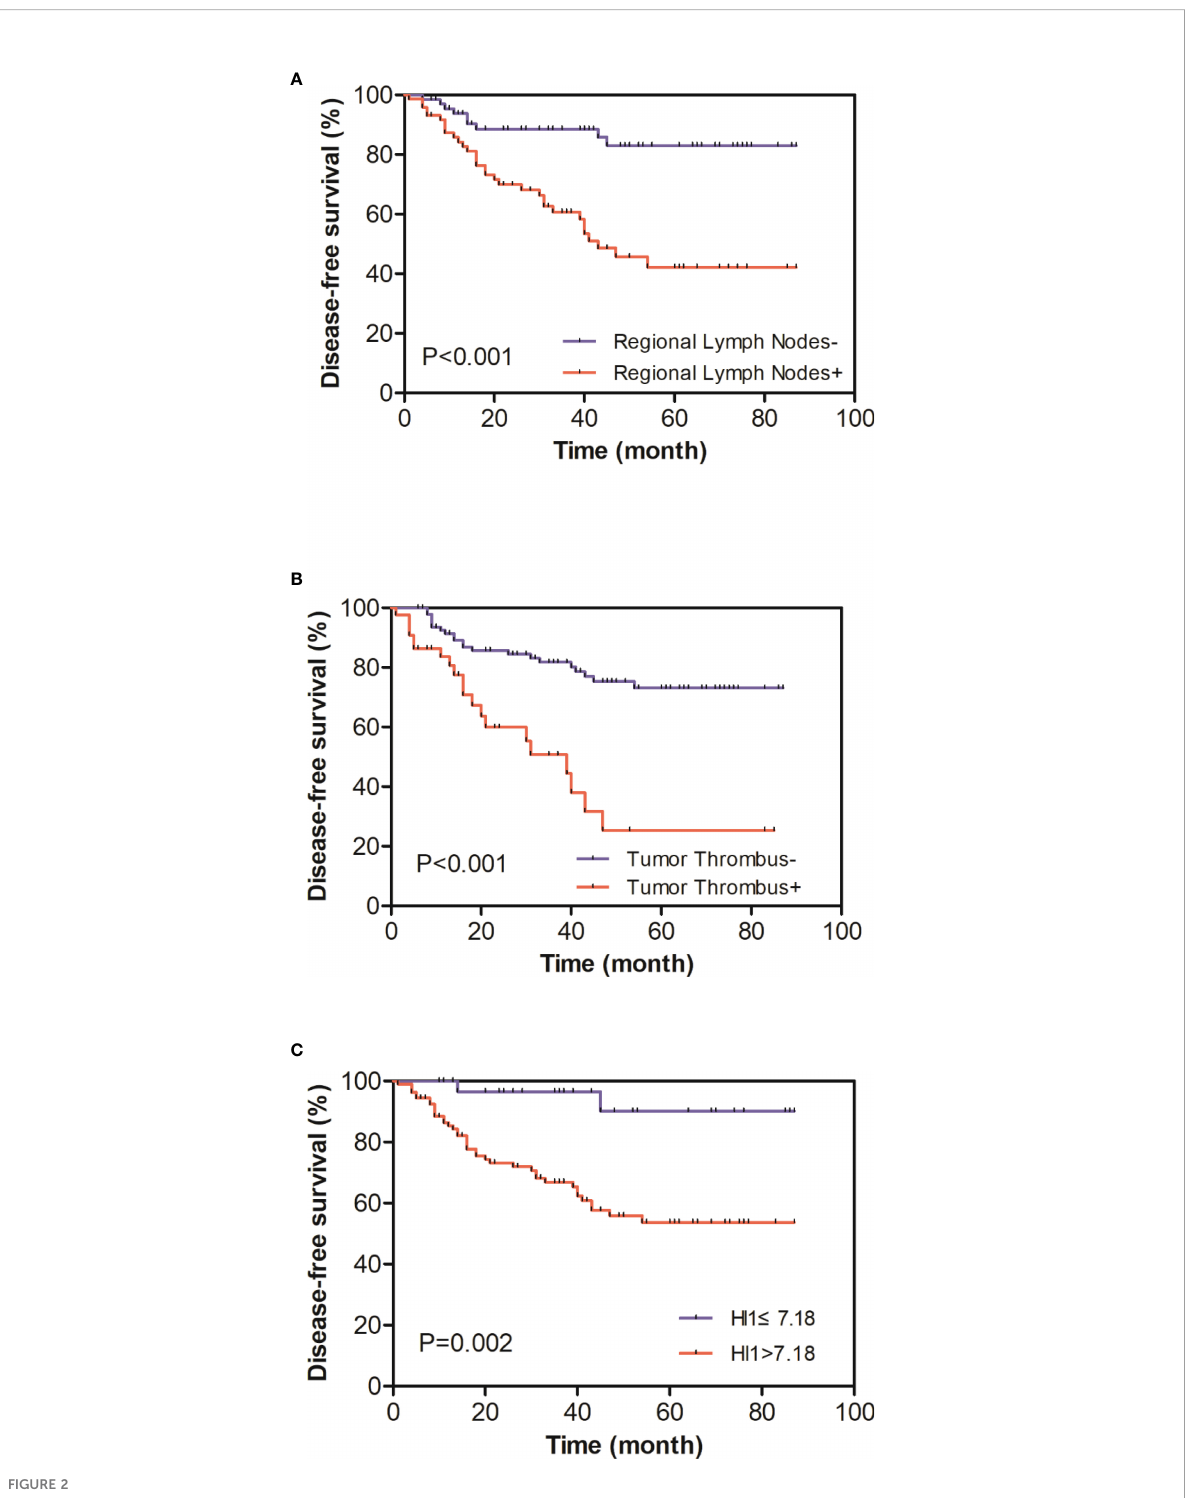
FIGURE 2 (A) Kaplan – Meier curves of disease-free survival (DFS) distinguished by regional lymph node status. (B) Kaplan – Meier curves of DFS distinguished by tumor thrombus status. (C) Kaplan – Meier curves of DFS distinguished by HI-1 (cutoff 7.18); patients with a higher HI-1 had a more severe